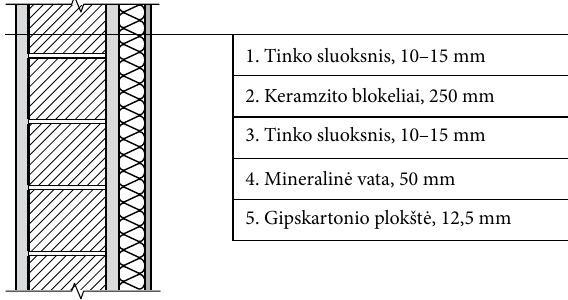
Fig. 5. Wall construction from expanded-clay concrete blocks